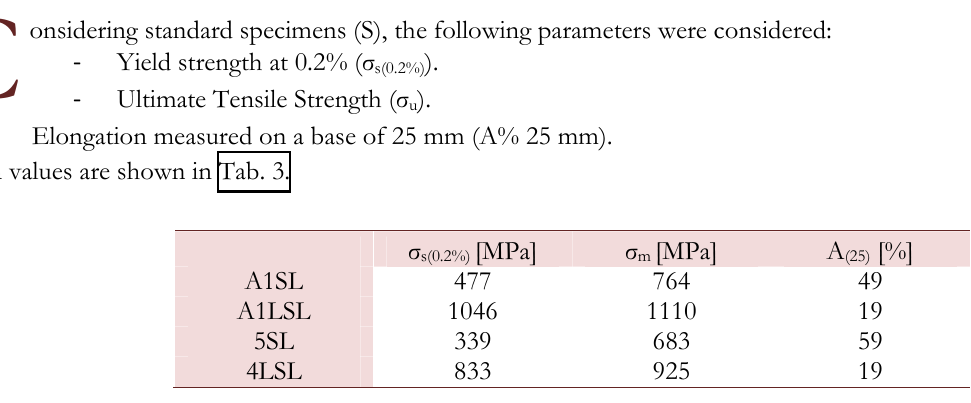
Table 3: Tensile test average results of standard specimen (S)